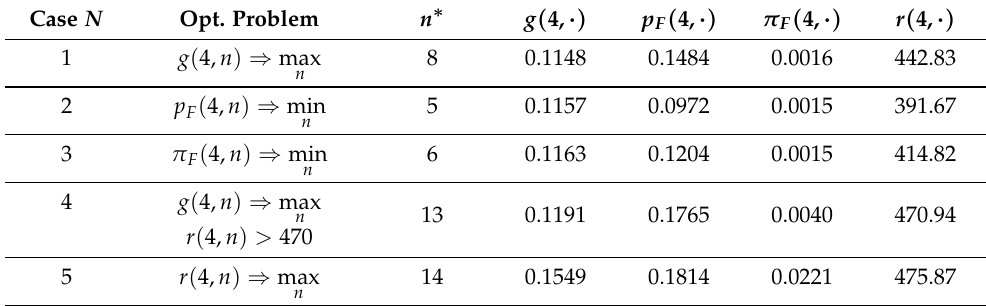
Table 2. Comparison of different optimization problems for the model with an instantaneous failure. Case N Opt.